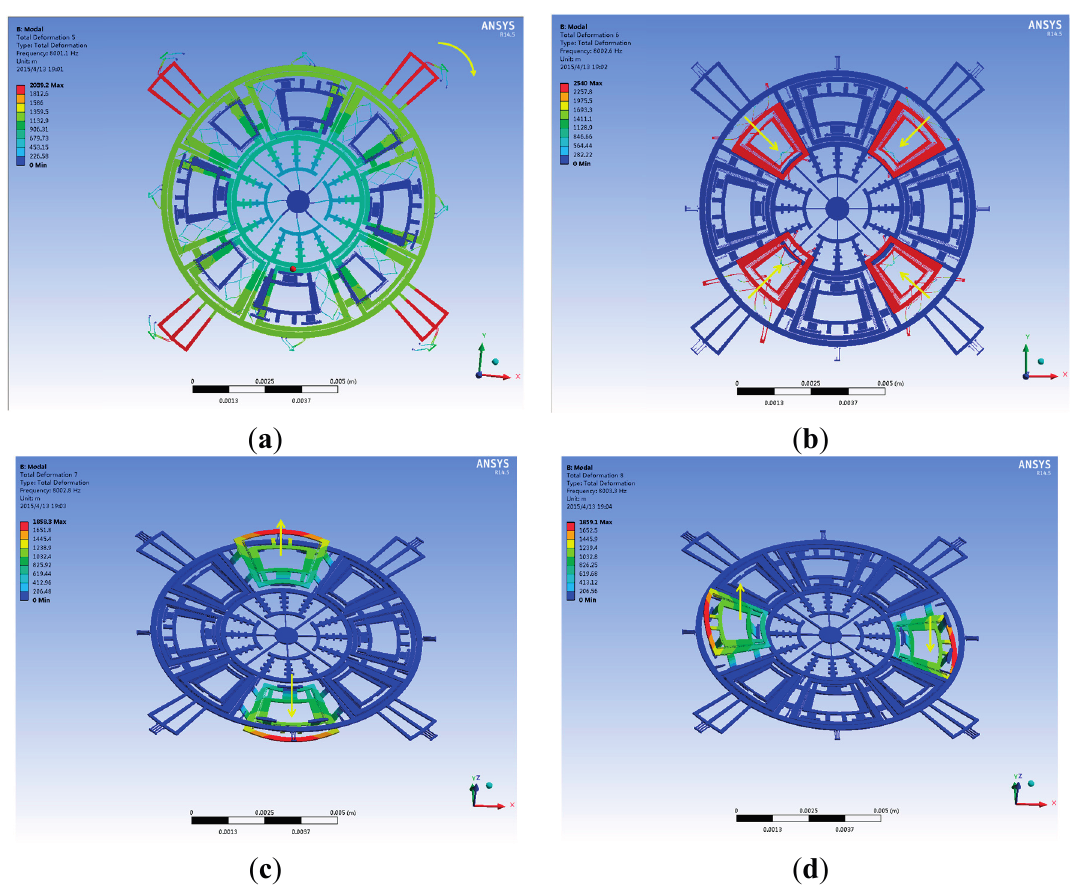
Figure 3. The desired modes of the tri-axis gyroscope: ( a ) The drive mode; ( b ) The yaw mode; ( c ) The pitch mode; ( d ) The roll